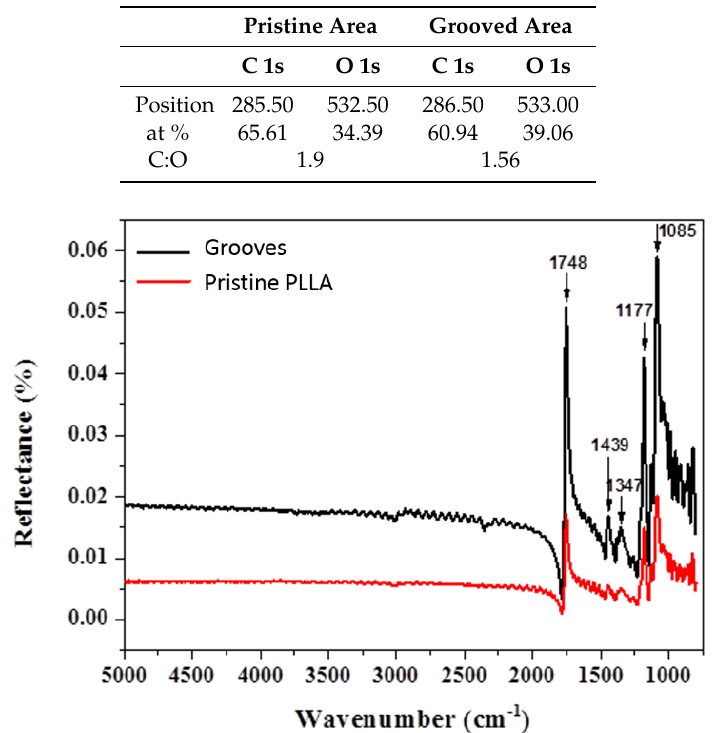
Figure 3. Infrared spectra of grooved and pristine areas of an amorphous PLLA film. Black and red lines represent spectra of grooved and pristine PLLA areas respectively.